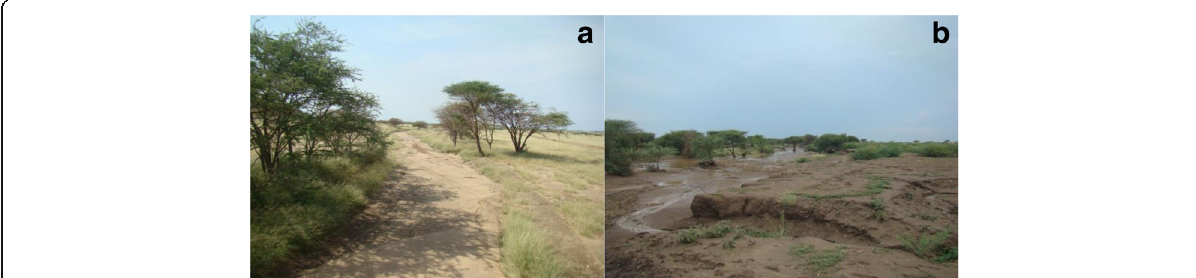
Figure 5 Comparison of cultivation practices along valleys between a small-scale farming by local inhabitants of Butana, where the tree cover has been maintained, and b LSMA by LSFs where the tree cover has been uprooted using heavy